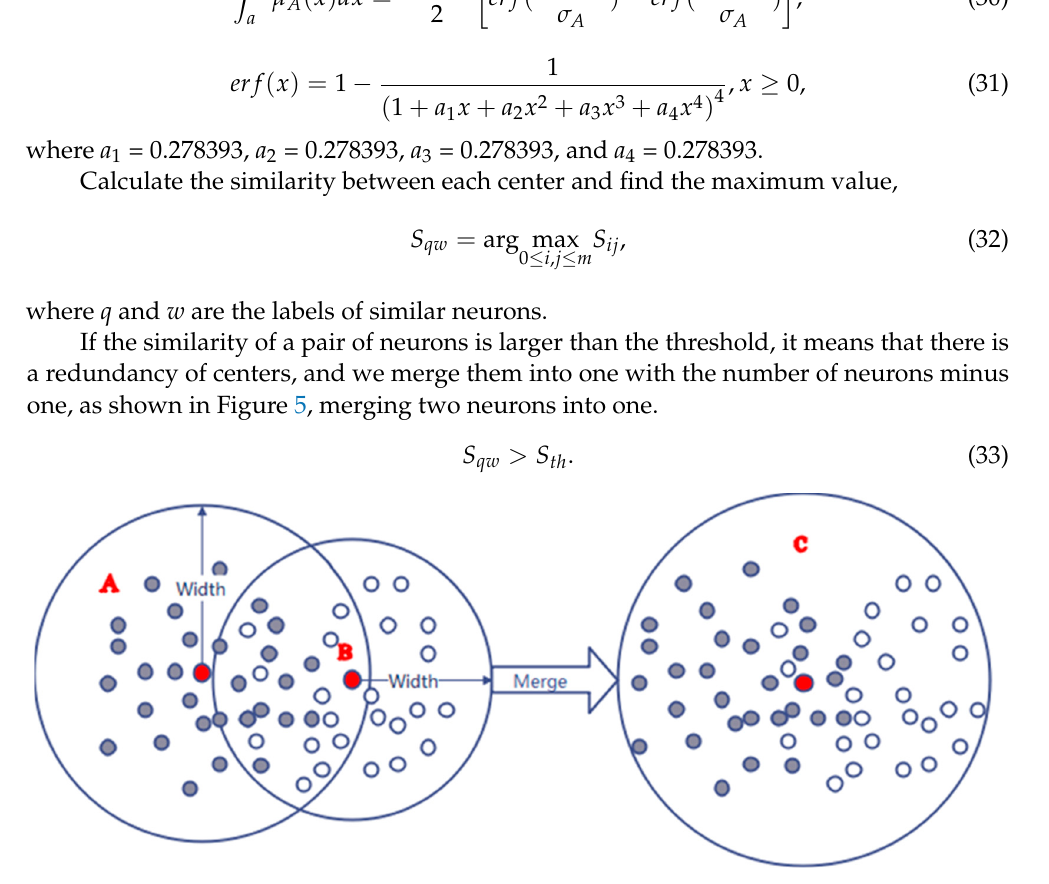
Figure 5. Schematic diagram of neuronal merger(A and B are overlapping neurons, and C is the merged neuron).